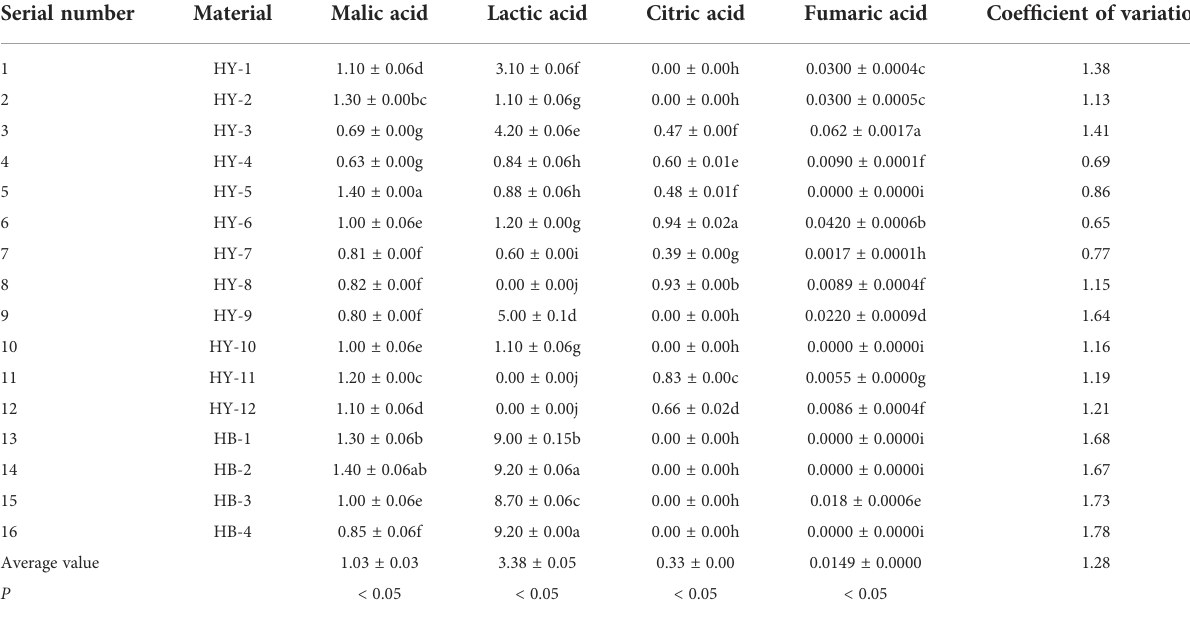
TABLE 7 The content of organic acid in the pulp of different genotypes of A. trifoliata